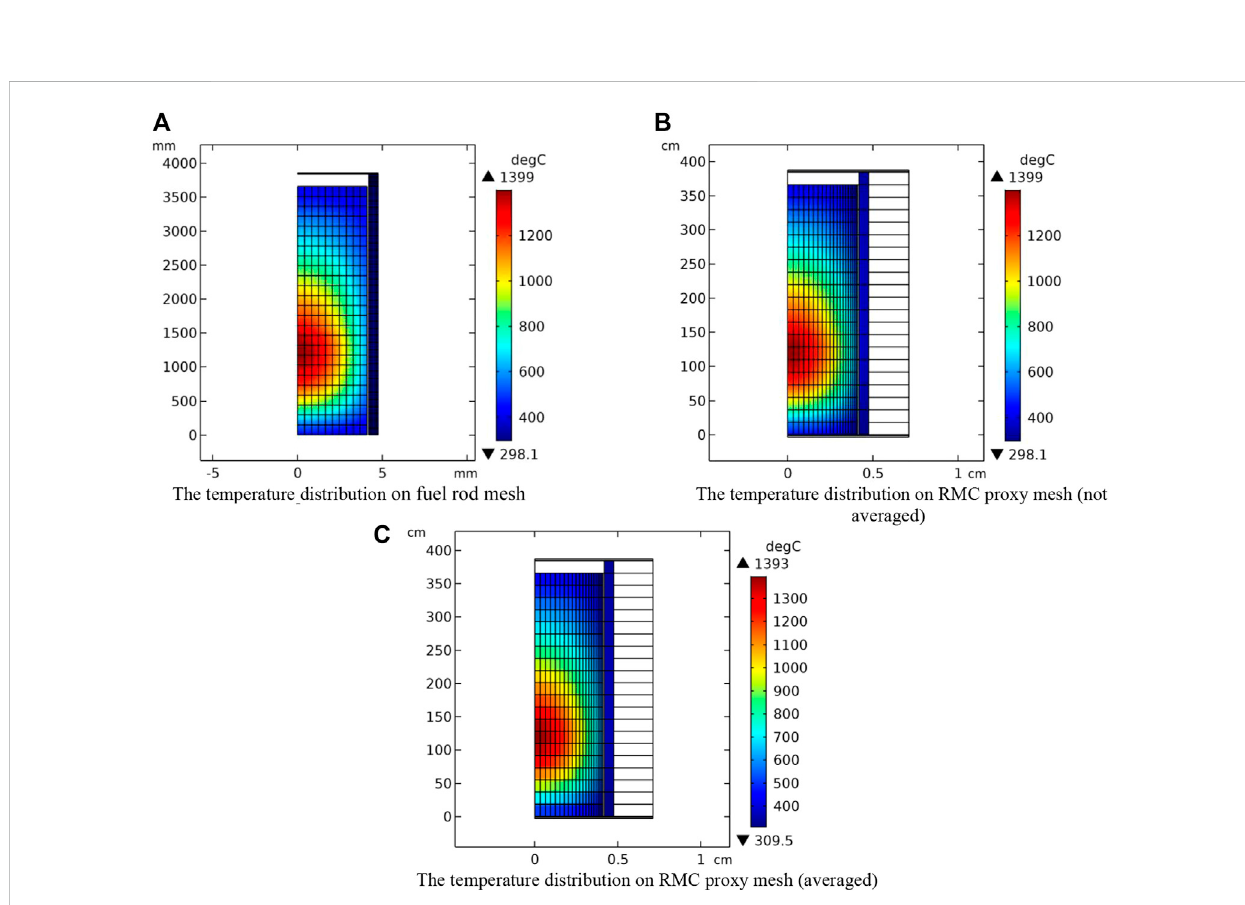
FIGURE 3 Temperature distribution on fuel rod mesh (A) , RMC proxy mesh (not averaged) (B) and RMC proxy mesh (averaged) (C)